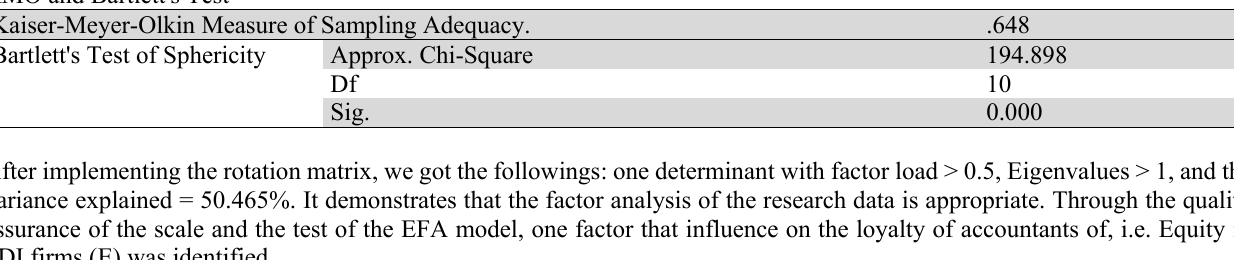
Scale Mean if Scale Variance if Item Deleted Item Deleted